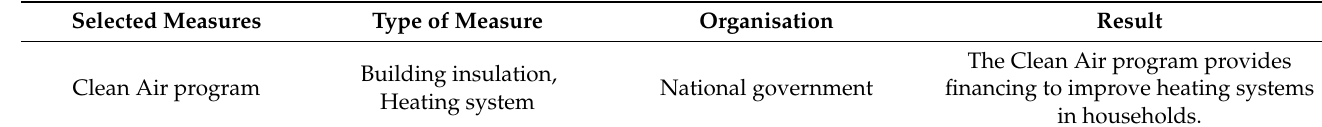
Table 9. Instruments for combating energy poverty used in